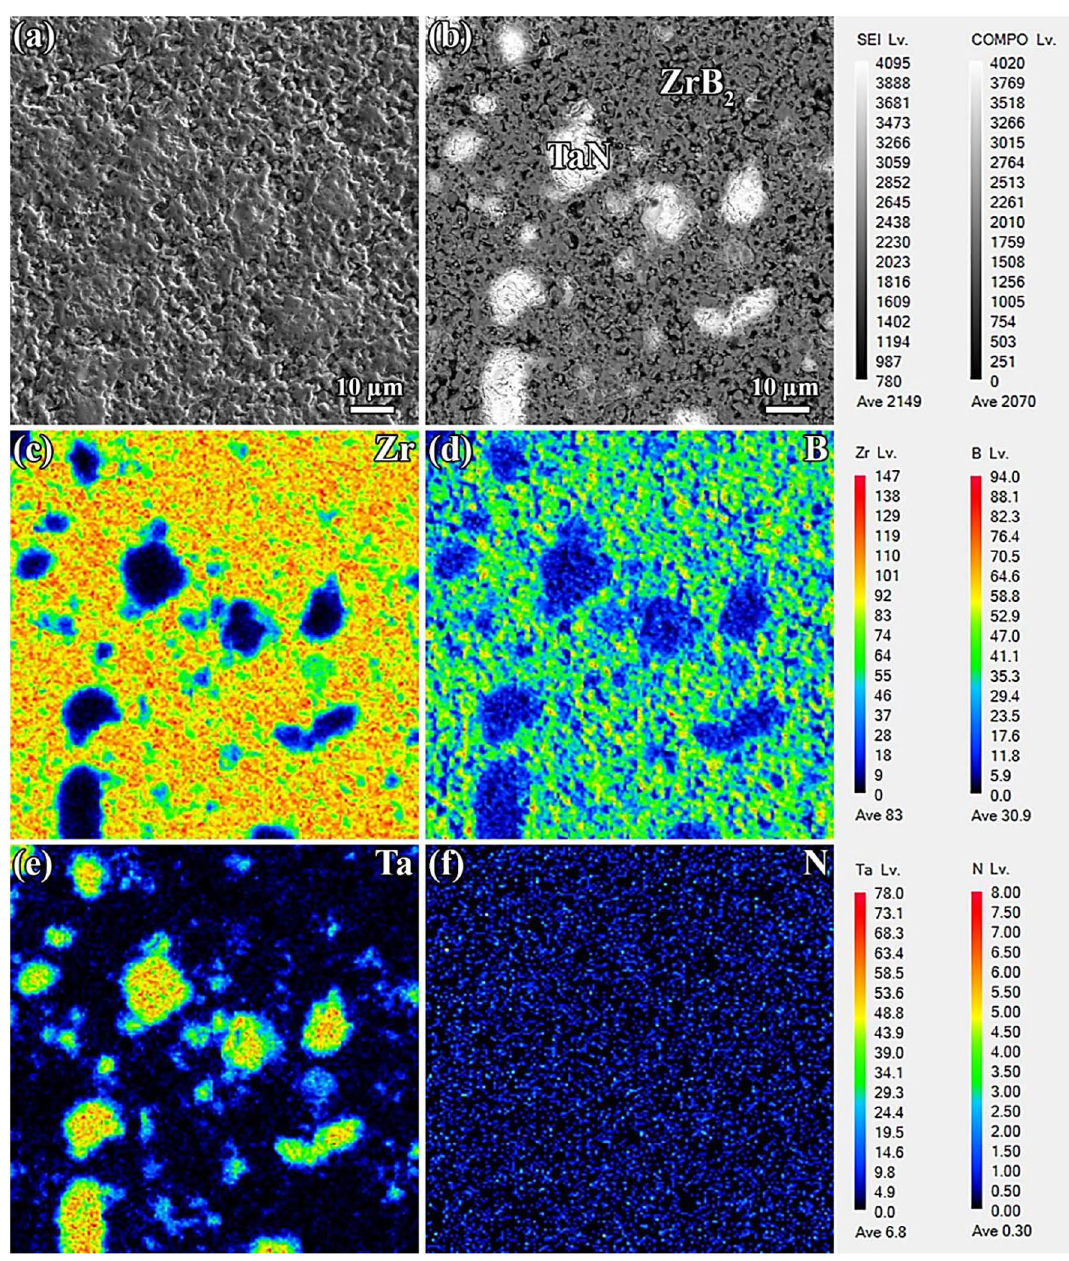
Figure 5. ( a and b ) FESEM images of polished surface of ZrB 2 -TaN, and ( c – f ) the corresponding EPMA